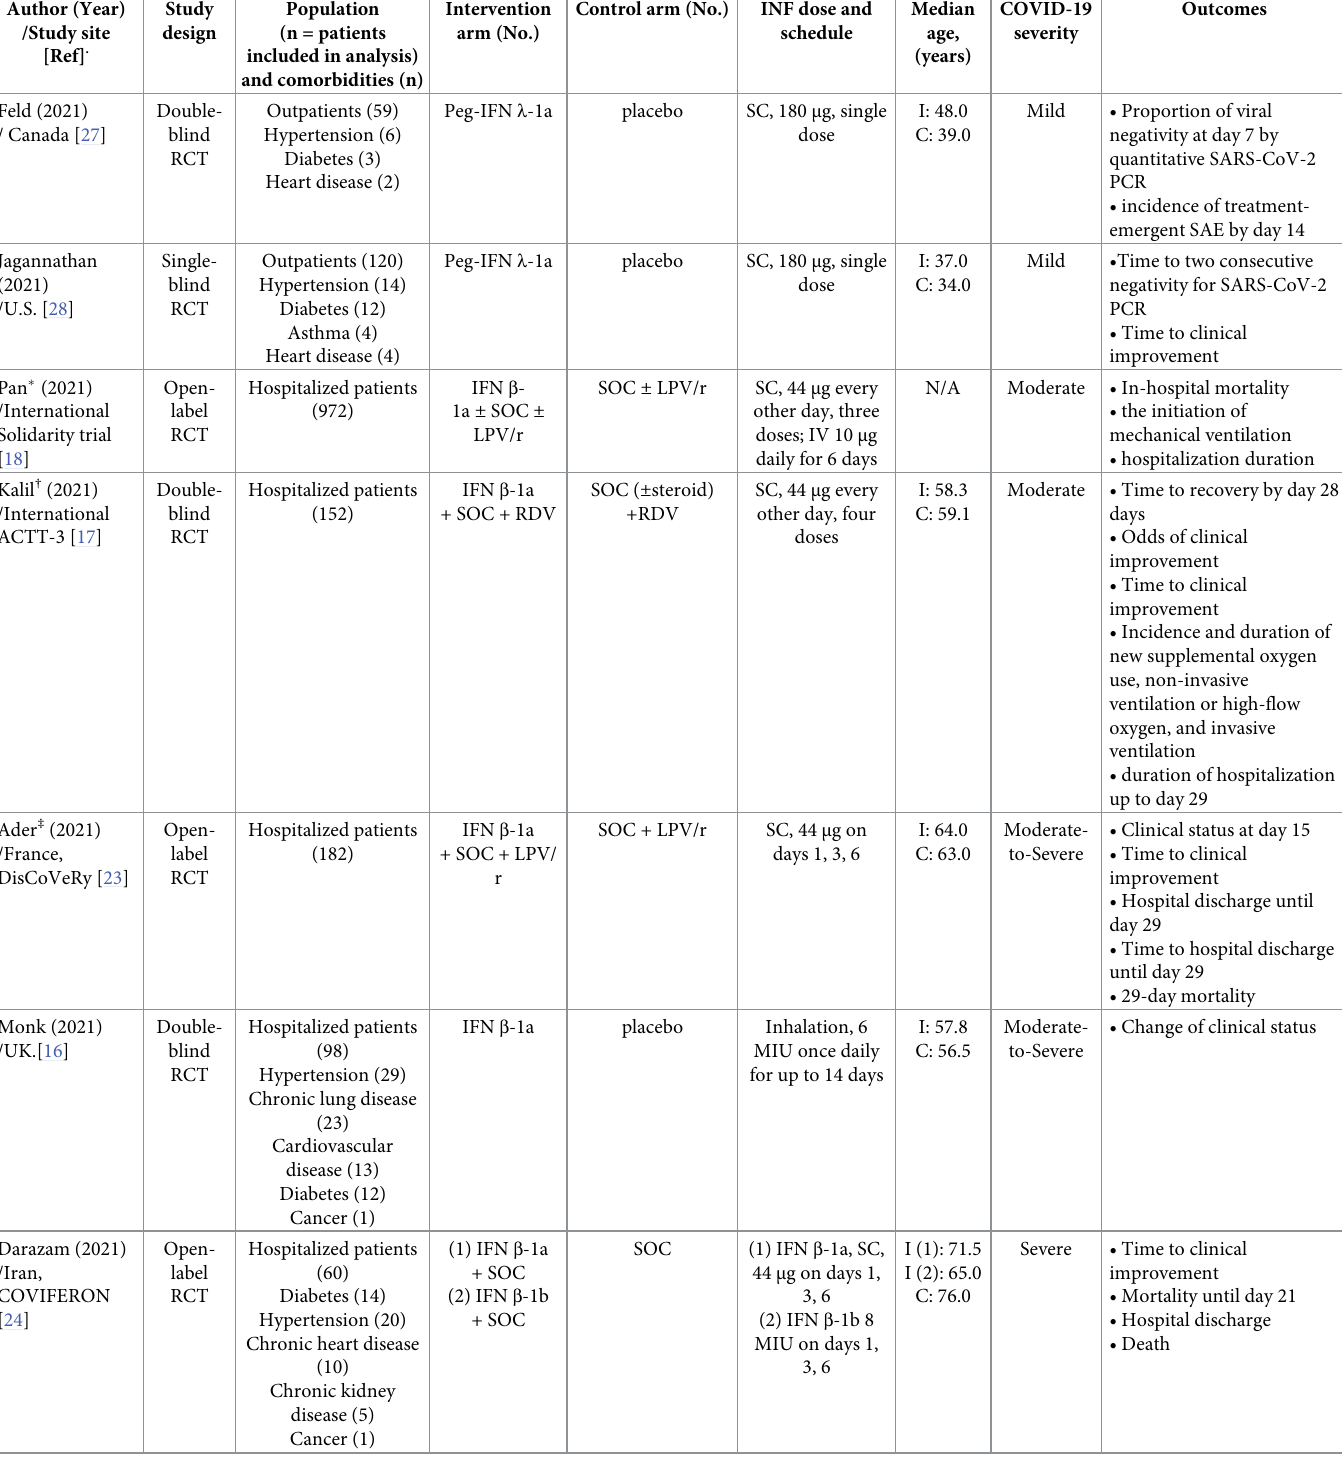
Table 1. Baseline study characteristics of published randomized controlled trials of